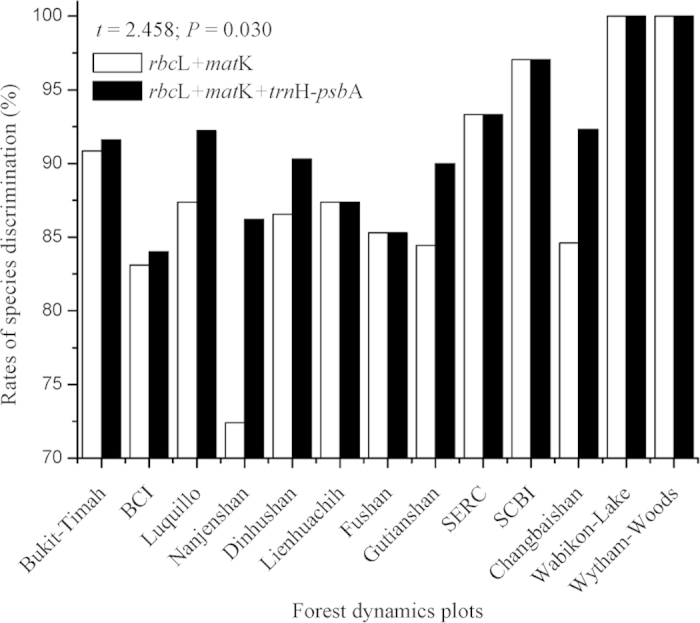
Species discrimination rates of rbcL + matK and rbcL +  matK + trnH–psbA among the thirteen forest dynamics plots.